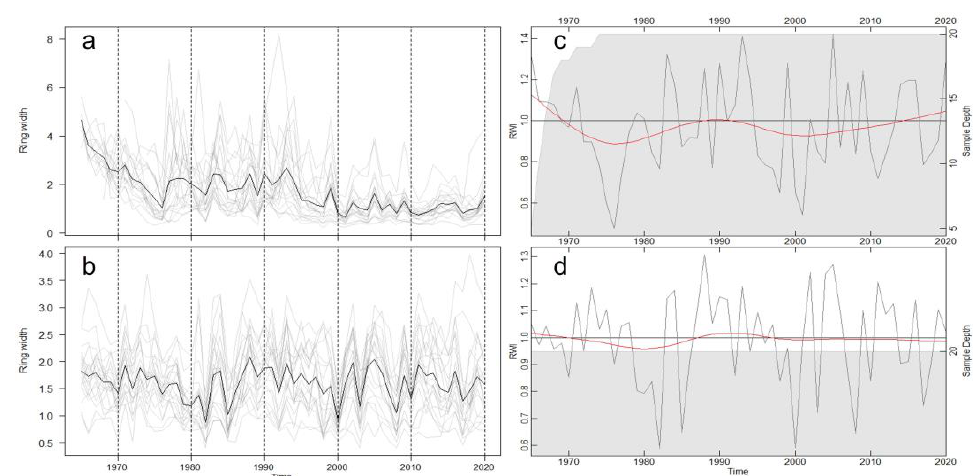
Figure A1. Tree-ring width chronology from ( a , c ) Harbin ( a , raw; c , detrended) and ( b , d ) Mao’ershan ( b , raw; d , detrended). The tree-ring width chronologies were detrended with a 30-year spline to remove radial and height growth.